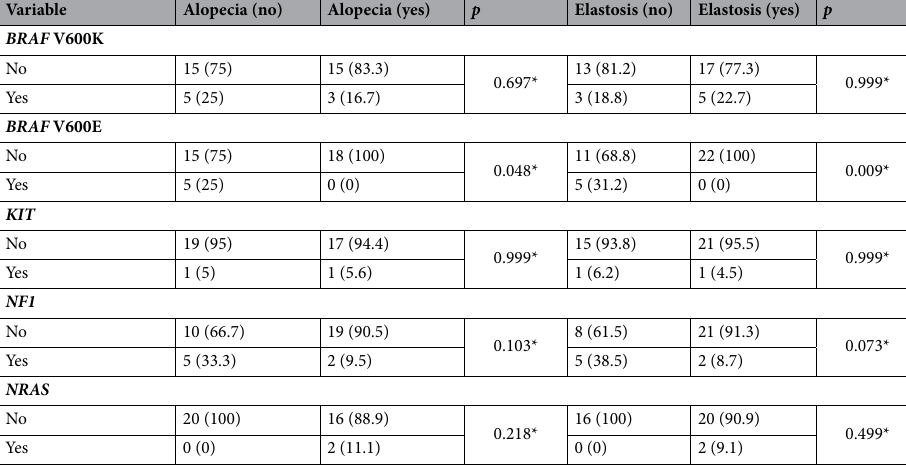
Table 1. Clinical and histopathological characteristics of scalp melanoma patients according to the presence of androgenetic alopecia. *Fisher’s exact test; **Student’s t-test; ***Mann–Whitney test; ****Chi-square